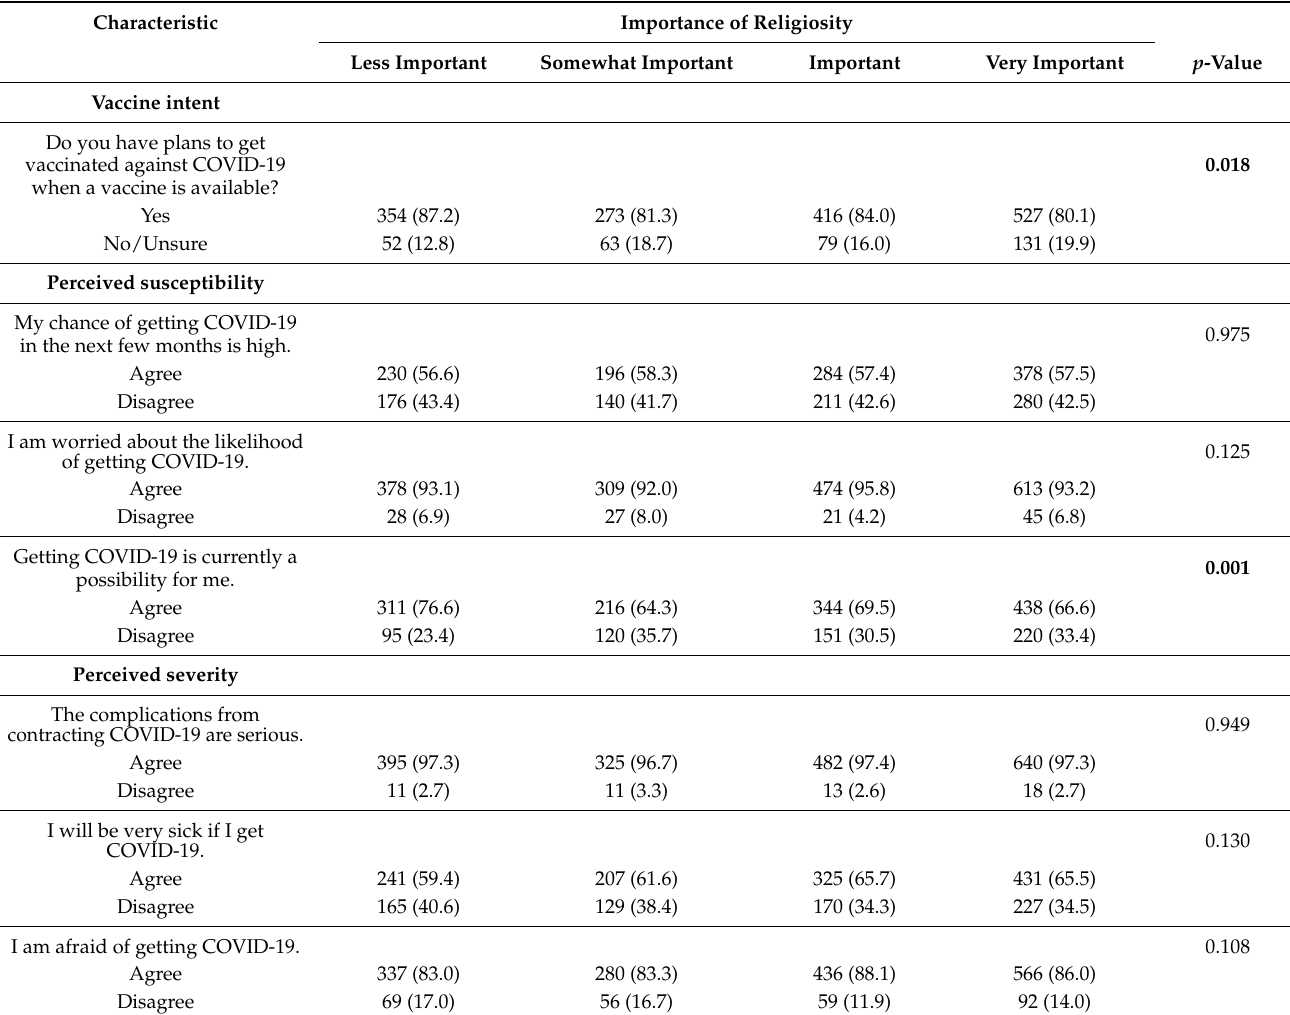
Table 2. Bivariate association between vaccine hesitancy predictors and importance of religiosity among adults in Puerto